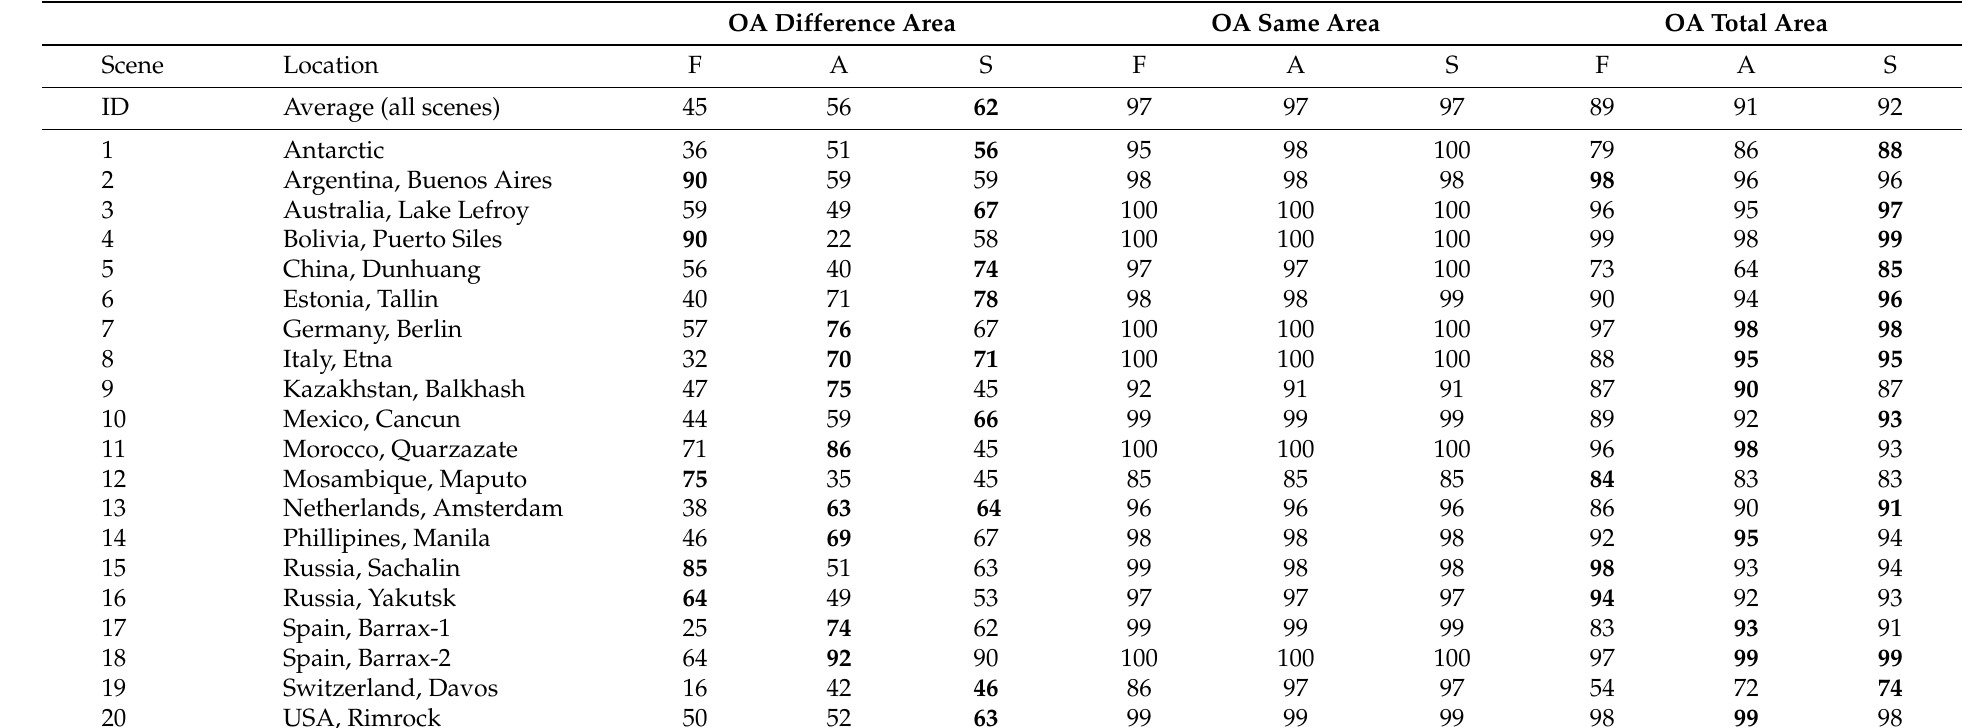
Table 5. Summary of overall accuracy (percent) (F = Fmask, A = ATCOR, S =